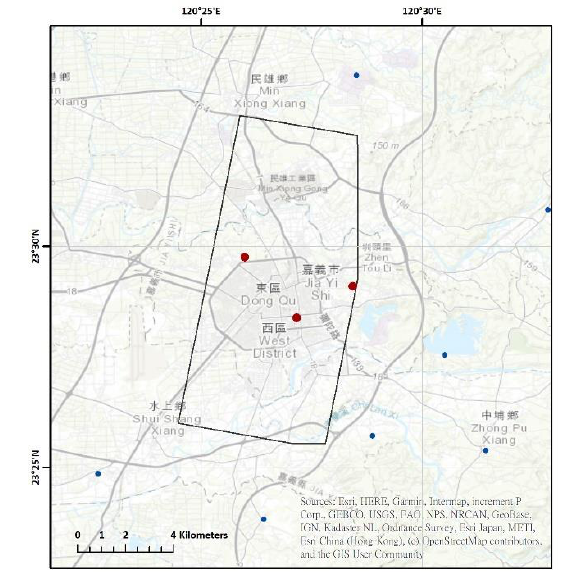
Figure 4. 3 GPS stations located inside of the test